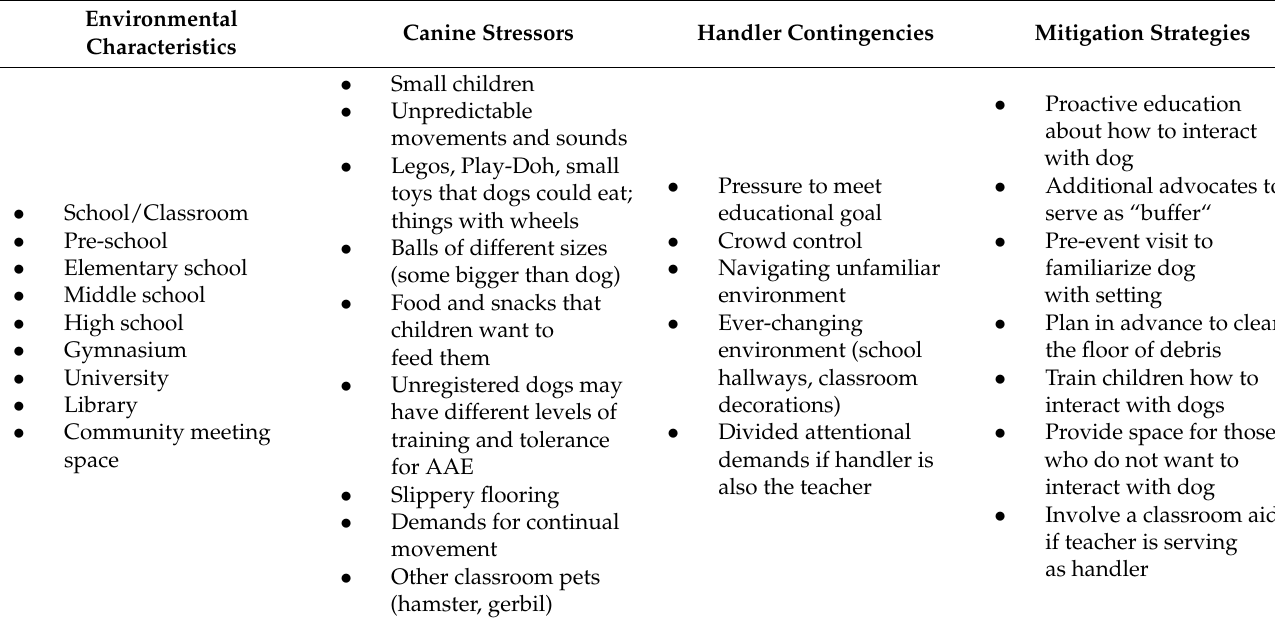
Table 2. Canine Stress Mitigation Strategies for Animal-assisted Education Contexts.